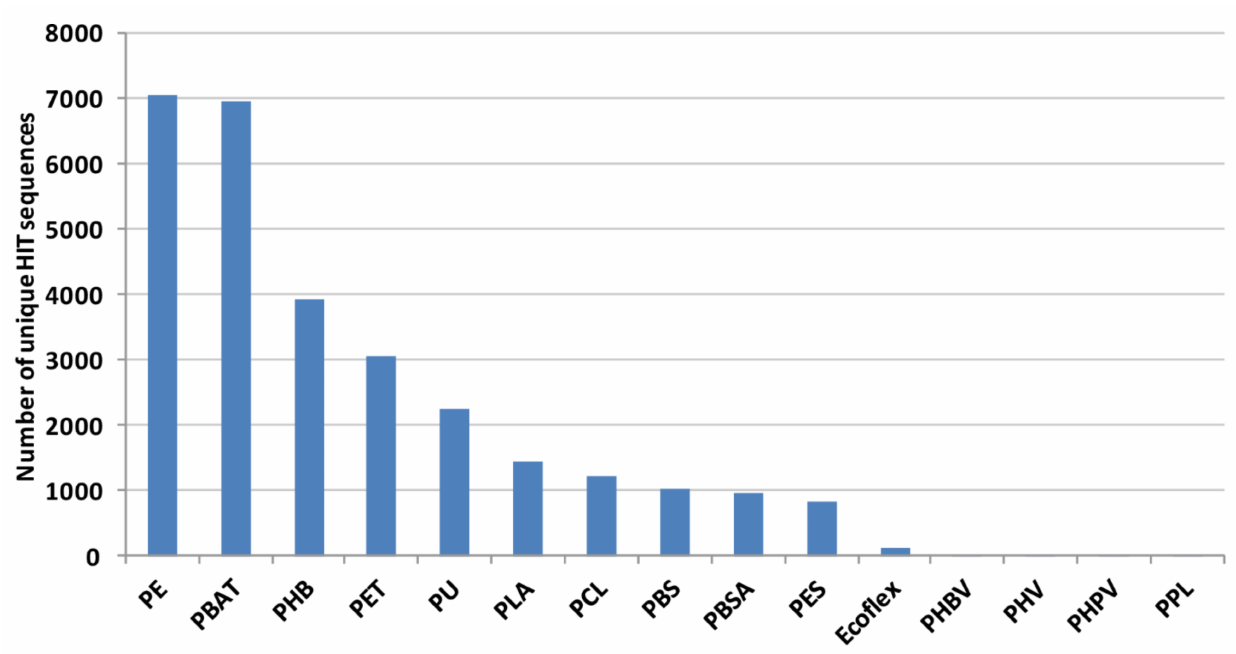
Figure 3. Total number of unique HIT sequences identified in Rhodococcus genomes for each poly- mer